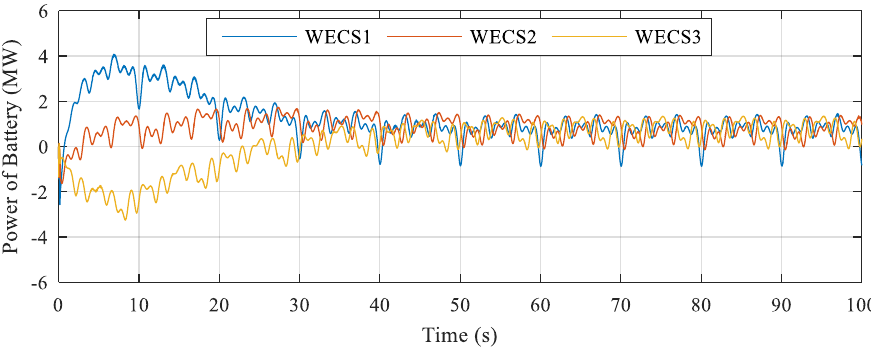
Figure 12. Power of battery with the proposed controller (Case 1).